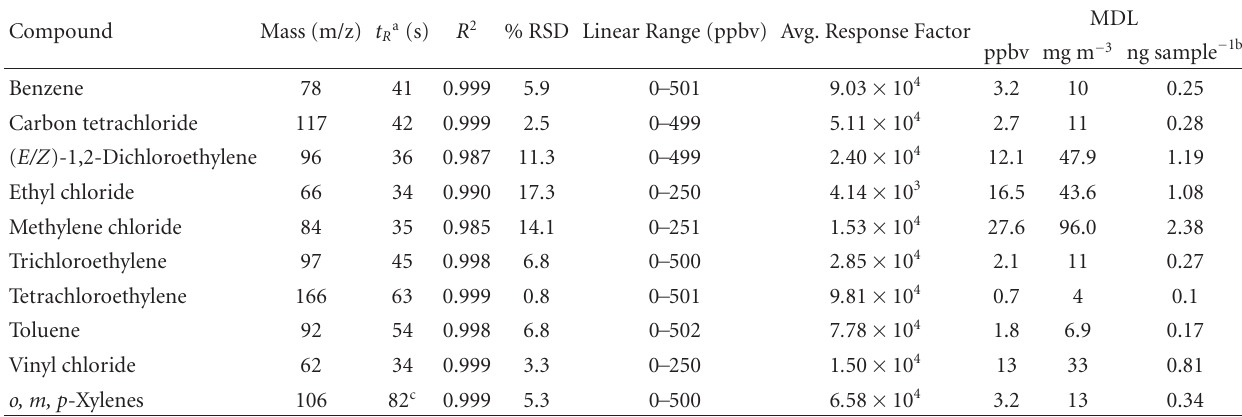
Table 4: Method validation results.